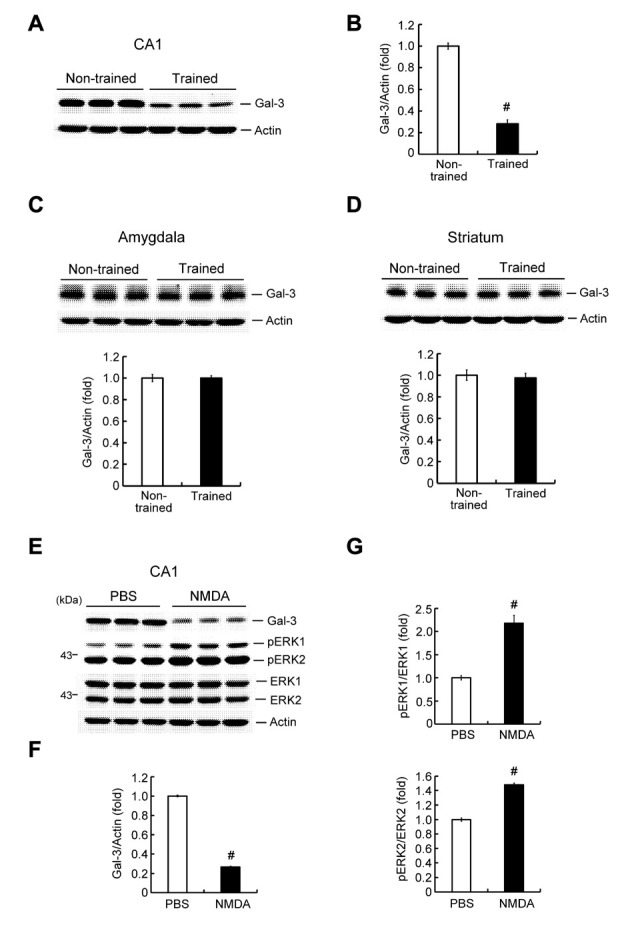
Contextual fear-conditioning training and NMDA decrease galectin-3 expression in the rat hippocampus. (A) Western blot showing galectin-3 expression in the CA1 area of trained and non-trained rats. (B) Quantitative analysis of galectin-3 expression in CA1 area of trained and non-trained rats (t(1,18) = 15.27, P < 0.001). (C) Western blot and quantitative analysis of galectin-3 expression in the amygdala of trained and non-trained rats (t(1,18) = 0.02, P > 0.05). (D) Western blot and quantitative analysis of galectin-3 expression in the striatum of trained and non-trained rats (t(1,18) = 0.38, P > 0.05). N = 10 each group. (E) Western blot showing the effect of NMDA injection (12.5 mM) on the expression level of galectin-3 and pERK in rat CA1 area. Quantitative analysis of the effect of NMDA on (F) Galectin-3 expression (t(1,10) = 51.11, P < 0.001) and (G) pERK1/ERK1, pERK2/ERK2 levels (t(1,10) = 6.69, P < 0.001 for pERK1 and t(1,10) = 15.12, P < 0.001 for pERK2) in the CA1 area. N = 6 each group. Data are mean ± SEM. #P < 0.001.